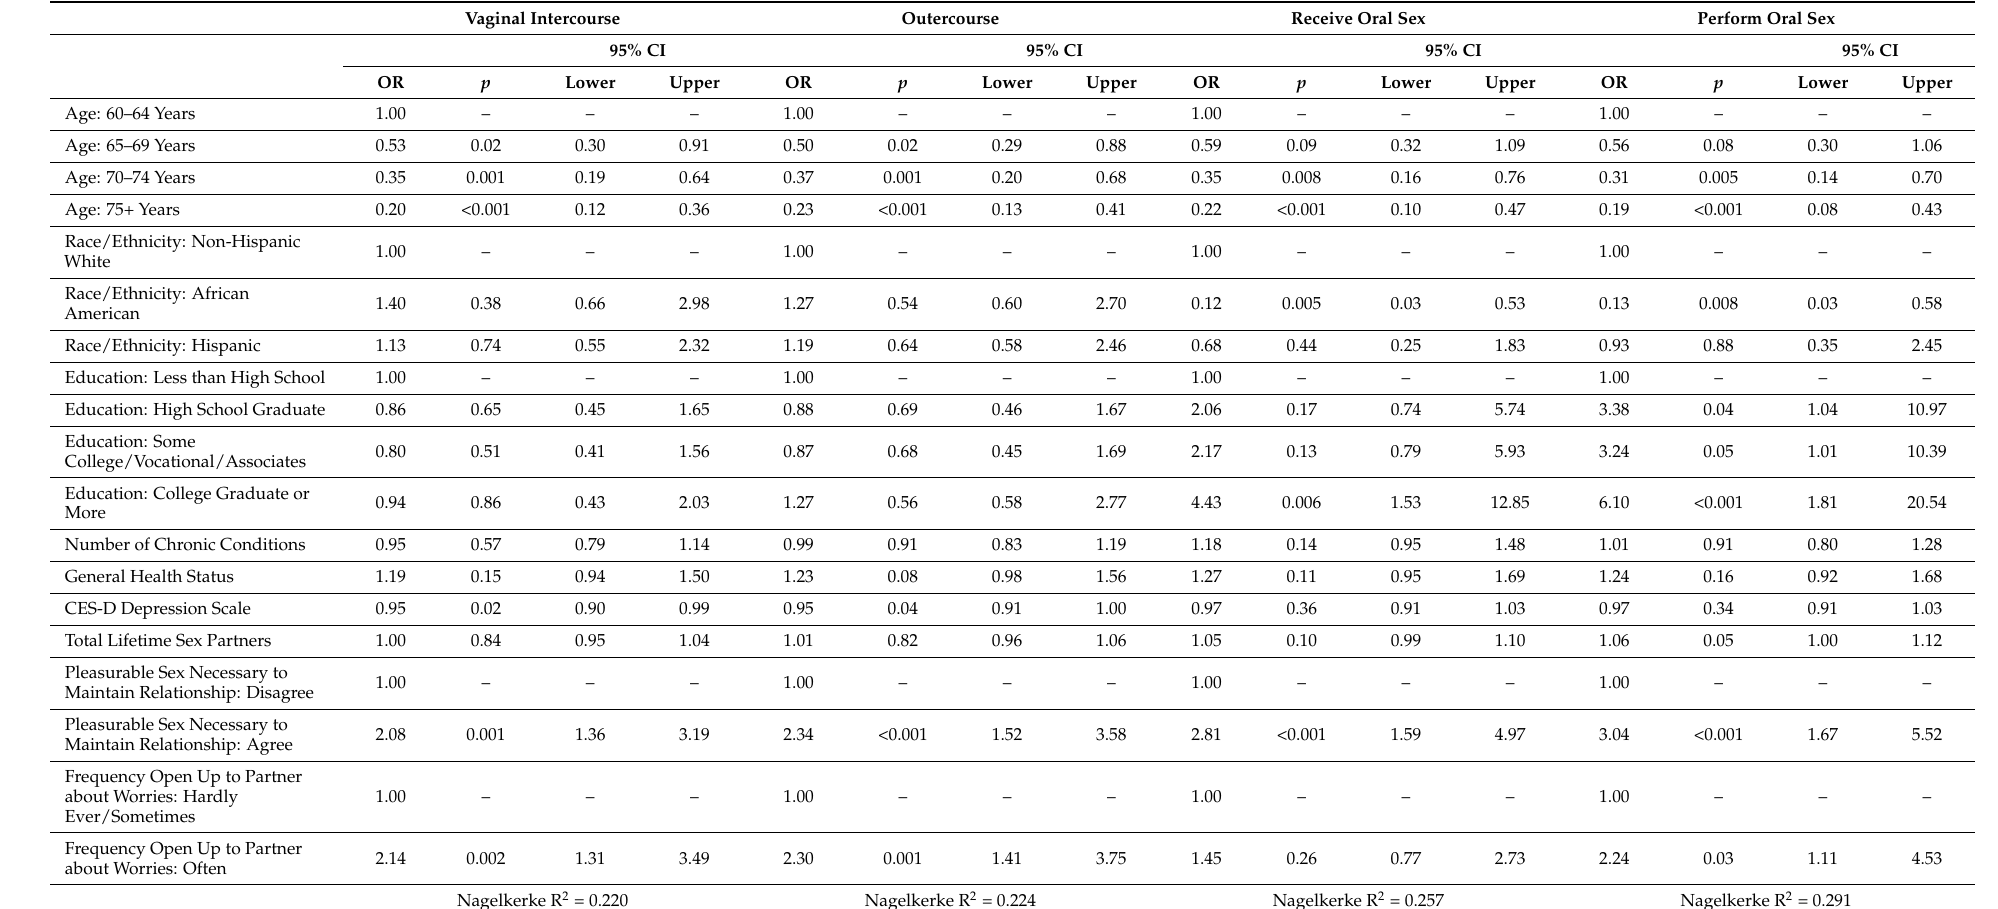
Table 1. Logistic Regression for Engaging in Sexual Behaviors Within the Past